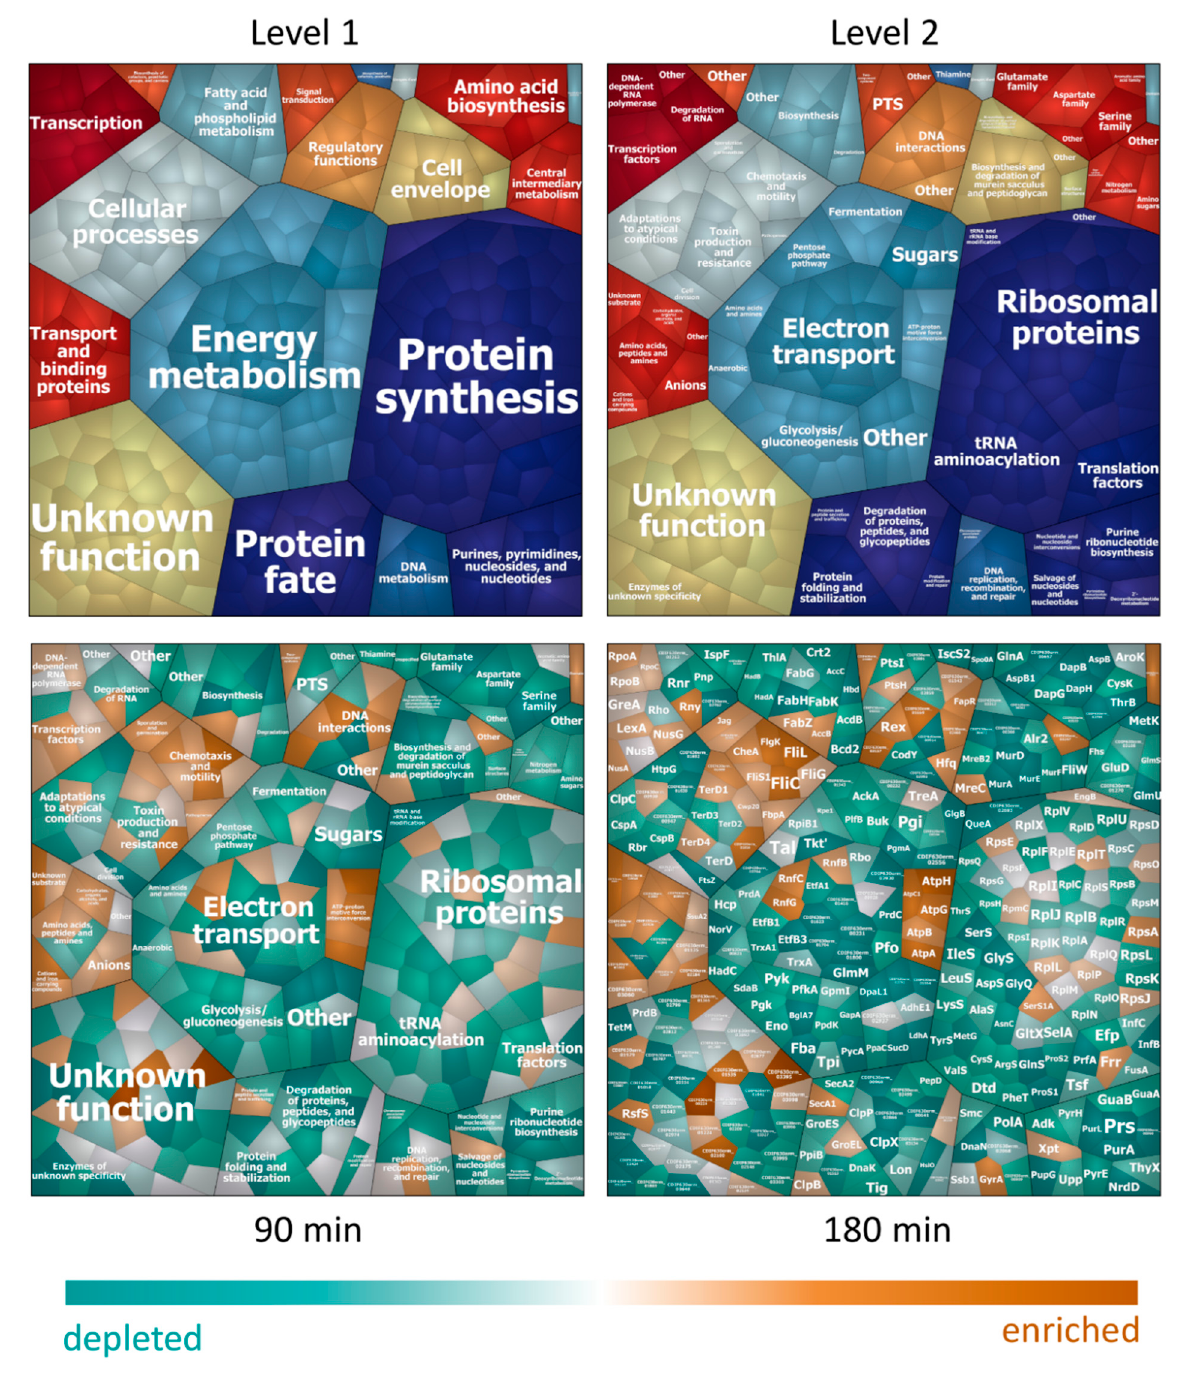
Figure 2. Voronoi Treemaps for proteins in the cytosolic fraction. Proteins predicted to be located in the cytosol or with unknown localization, which were quantified in the cytosolic fractions of all samples, are depicted in tiles and were hierarchically clustered according to TIGRFams. The upper part of the figure displays the first two cluster levels of assigned functions. The third level displaying protein names for every single tile is shown in the map for timepoint 180 min. A list of assigned functional groups to all proteins detected in the cytosolic fraction can be found in Supplemental Material (Supplemental Table S1). The lower part of the figures displays the relative protein abundance at 90 min ( left ) and 180 min ( right ) after nisin treatment compared to untreated control conditions, respectively. Tiles of proteins with higher abundance after nisin treatment are colored in shades of orange, tiles of proteins with lower abundance after treatment are colored in turquoise.